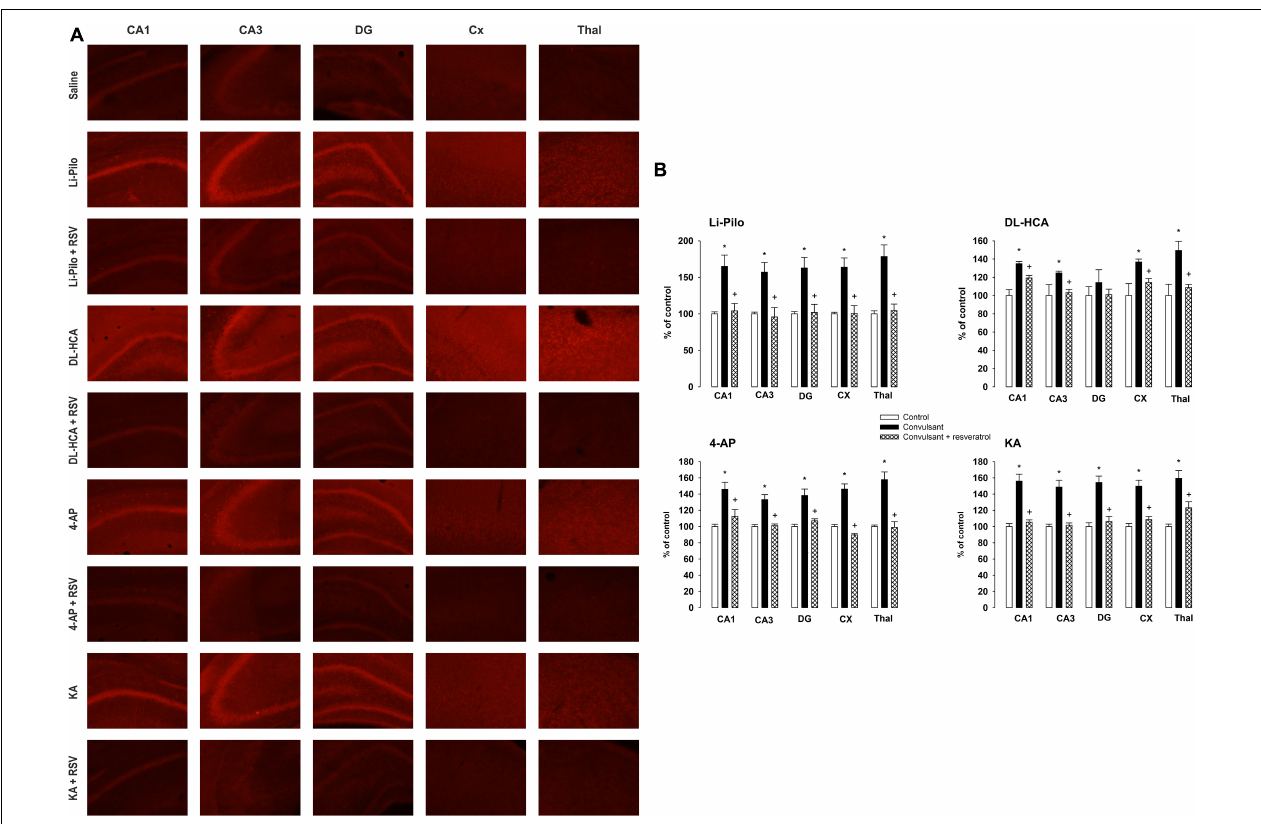
FIGURE 3 | (A) Fluorescence of the oxidized products of hydroethidium (reflecting superoxide anion production), assessed microscopically by fluorescence ( > 600 nm), in various brain structures following 60 min lasting SE induced by Li-Pilocarpine (Li-Pilo), homocysteic acid (DL-HCA), 4-aminopyridine (4-AP) or kainic acid (KA). Upper image for each model, convulsant agent alone; lower image for each model, convulsant agent plus resveratrol. (B) Effect of resveratrol on superoxide anion formation at 60 min following the onset of SE, induced in immature rats by Li-Pilo, DL-HCA, 4-AP, or KA. White columns, saline-treated controls; black columns, convulsant agent alone; cross-hatched columns, convulsant agent plus resveratrol. Results are expressed in percent, compared to 100% in the control animals. Mean values for 5–6 animals ± SEM. * P < 0.05 as compared with saline; † P < 0.05 as compared with convulsant agent alone. CA1 and CA3, hippocampal fields; DG, dentate gyrus; CX, cerebral cortex; Thal, dorsal thalamus.